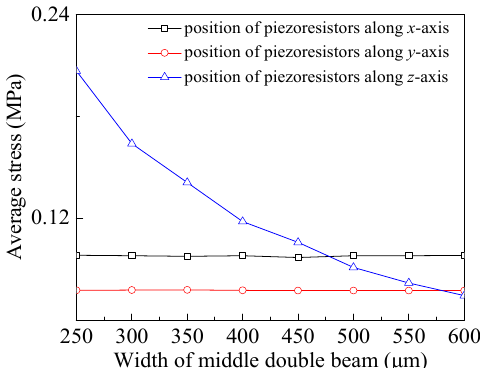
Figure 4. The relationship curves between the average stress at the piezoresistor positions along three axes and the width ( w ) of the intermediate double beams.